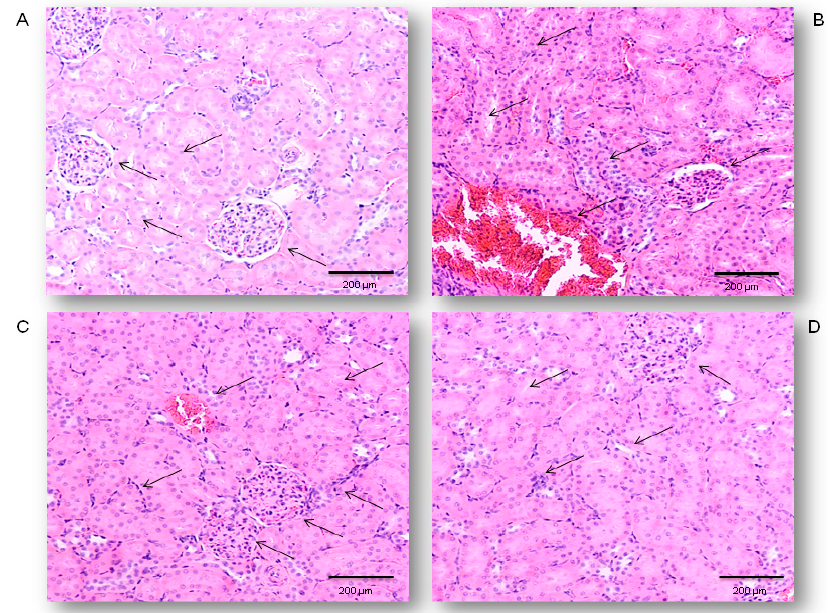
Figure 1. Protective effects of simvastatin pretreatment against LPS-induced acute renal damages, Hematoxylin and Eosin (H&E) method, 200 × magnified images, black arrows indicates the gromeruls and tubules. ( A ) Appearance of renal tissue of control animals, ( B ) renal tissue challenged with LPS, ( C ) renal tissue from simvastatin 20 group, ( D ) renal tissue from simvastatin 40 group. Histopathological analysis revealed decreased renal inflammatory damages in both simvastatin-treated groups, while severe alterations persisted only in the LPS-treated group.